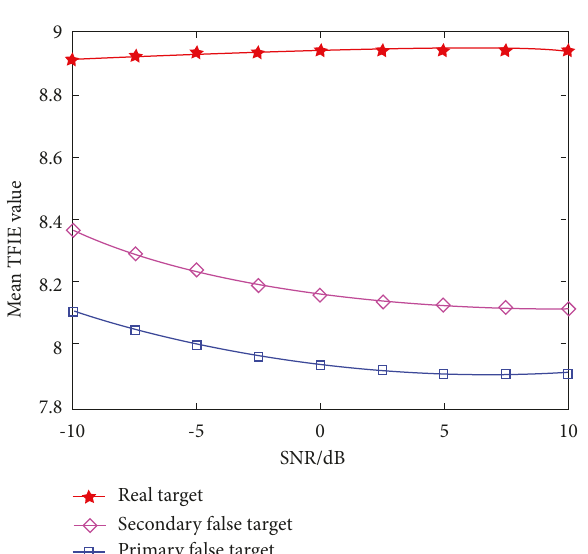
Figure 5: Mean TFIE value of targets. False targets are further divided into primary targets which are located in the middle of the false target group and other secondary